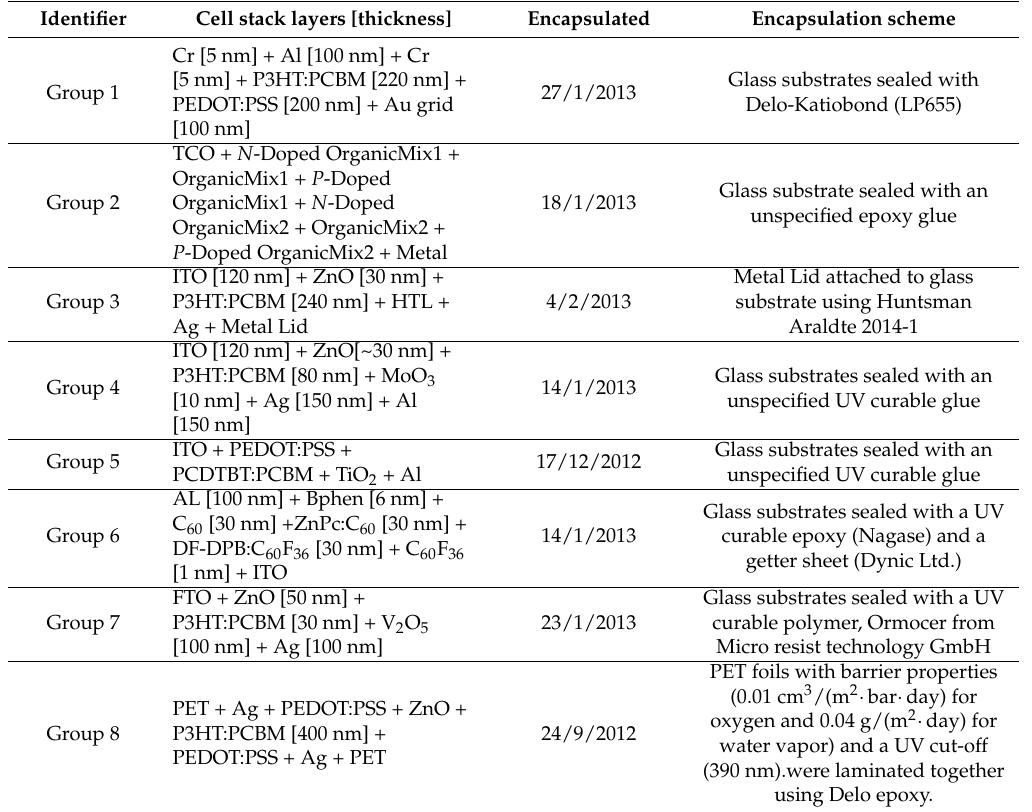
Table 2. Summary of Cells in Study.